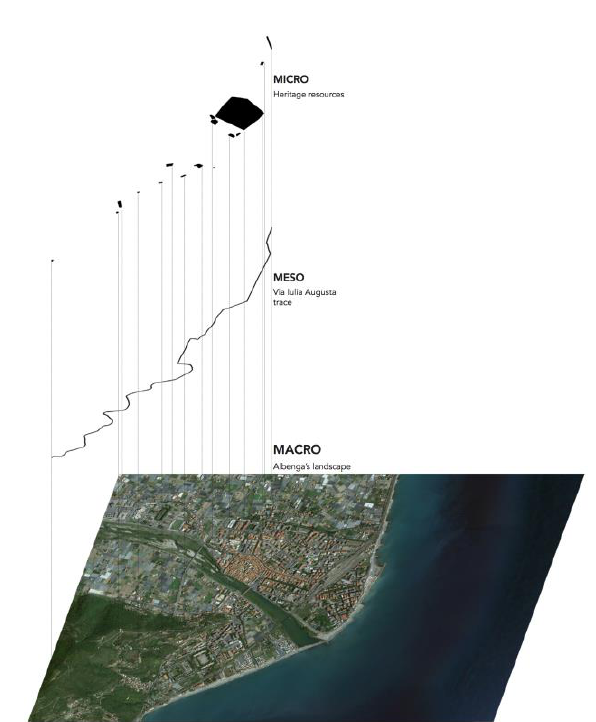
Figure 2. Three research levels for the case study of Albenga